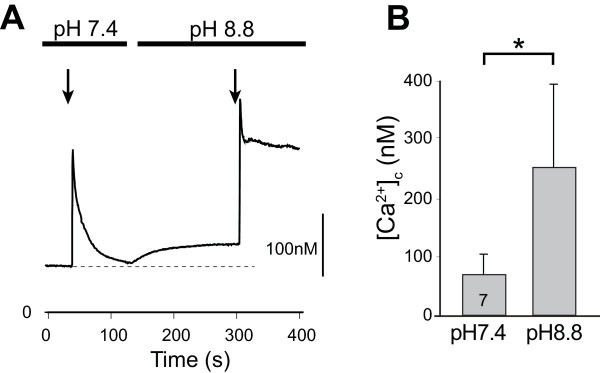
Blockade of PMCA in thapsigargin-treated neurons. Changing bath solution to pH 8.8 produced an increase in resting [Ca2+]c (A, B), and prevented recovery of transients (A) in neurons following blockade of SERCA with thapsigargin (100nM). Mean ± SD; number in bar indicates n; * P < 0.05 by paired T-test.